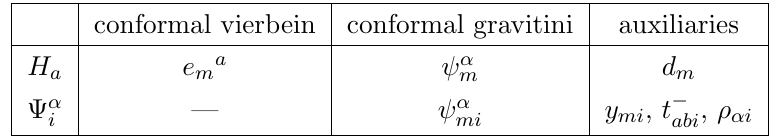
and superspin-1 super(cid:12)elds. 2